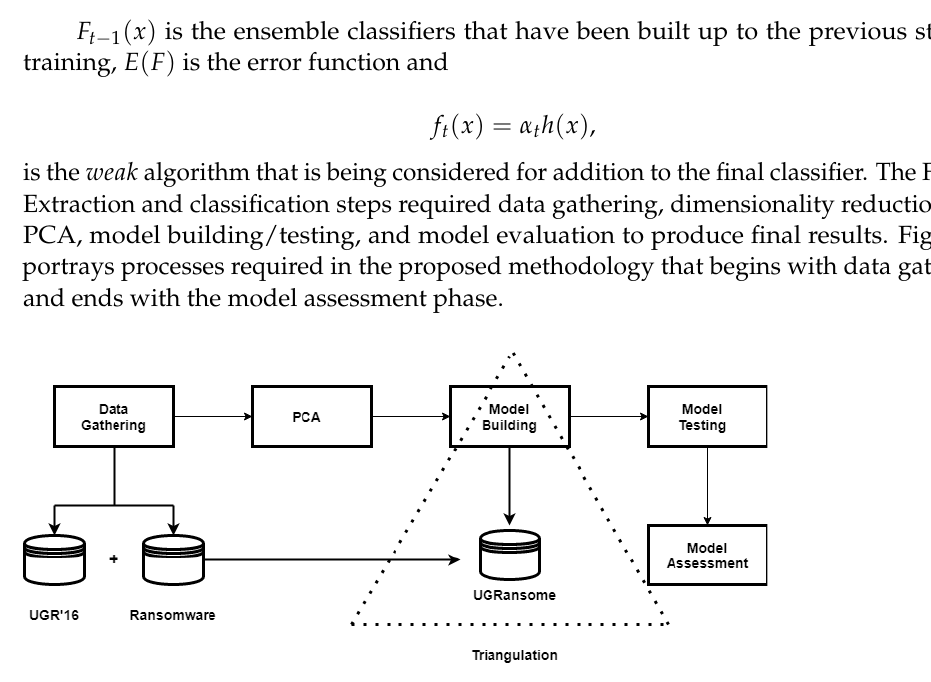
Figure 10. An overview of the suggested zero-day threats detection framework.